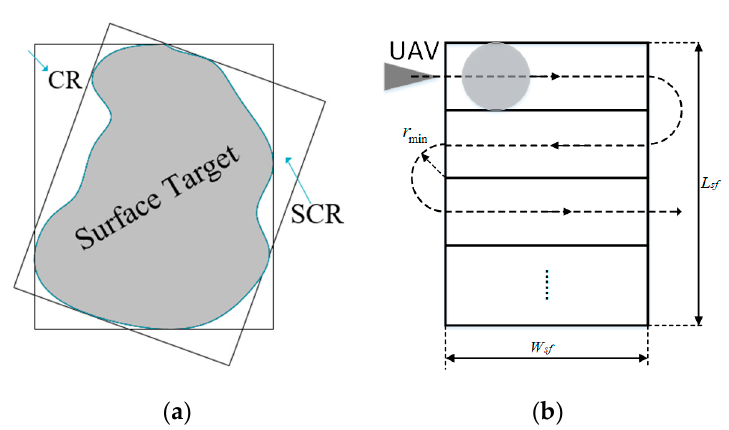
Figure 2. Reconnaissance of strip targets.